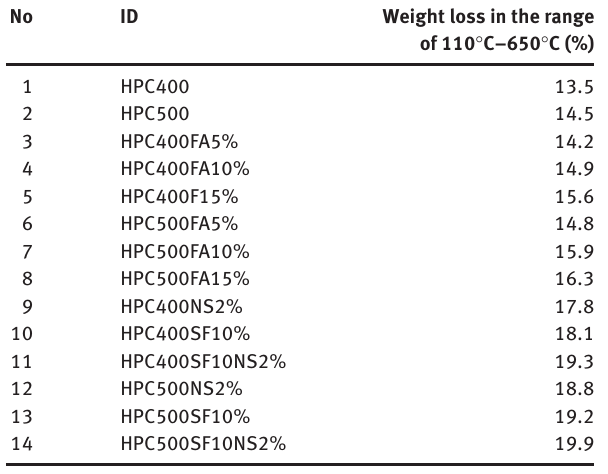
Table 5 Thermogravimetric analysis results of HPC